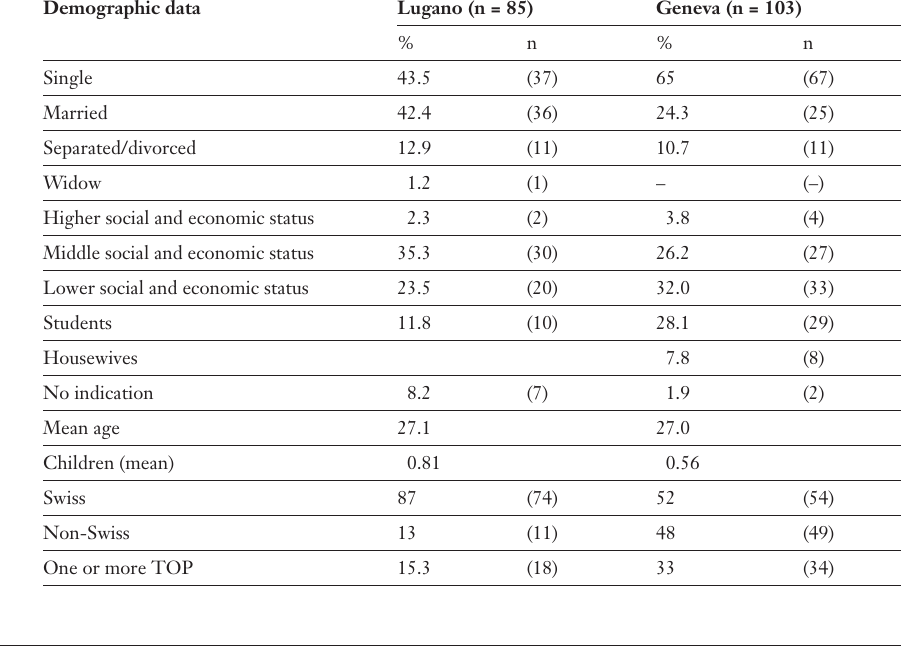
Demographic data: comparison Lugano–Geneva.